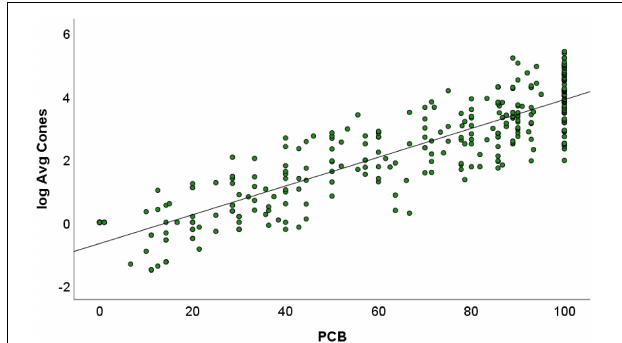
FIGURE 3 | Scatterplot of the percentage of trees bearing cones and log-transformed average cone production ( n = 314). The linear-fit line ( Y = 4.55X – 0.67) was statistically significant ( p < 0.001). Note the clustering of values when PBC = 100.